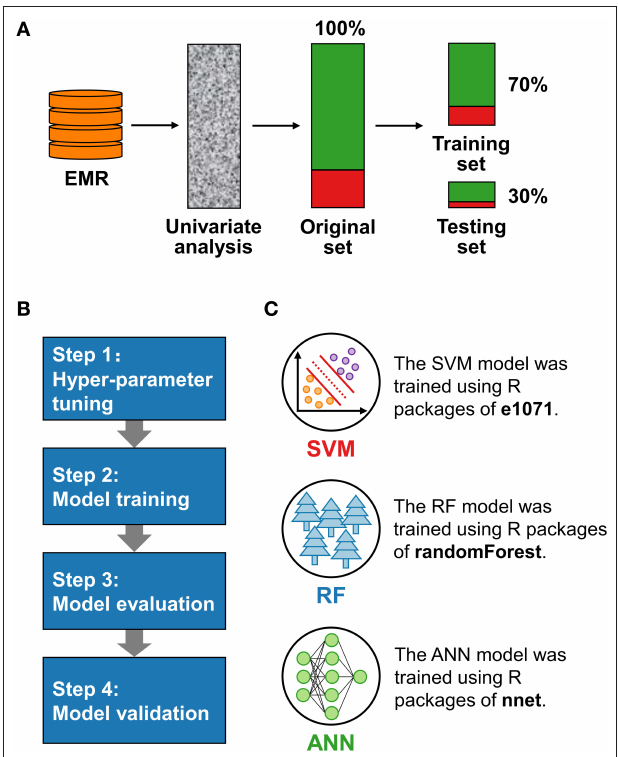
FIGURE 1 | Schematic diagrams of data processing and model development. (A) The data from electronic medical records (EMR) were selected by univariate analysis to form an original set, which was divided into training and test sets by stratified sampling. (B) Models were developed through a procedure with four steps. (C) Three machine learning algorithms, the support vector machine (SVM), random forest (RF), and artificial neural network (ANN), were used for model training.